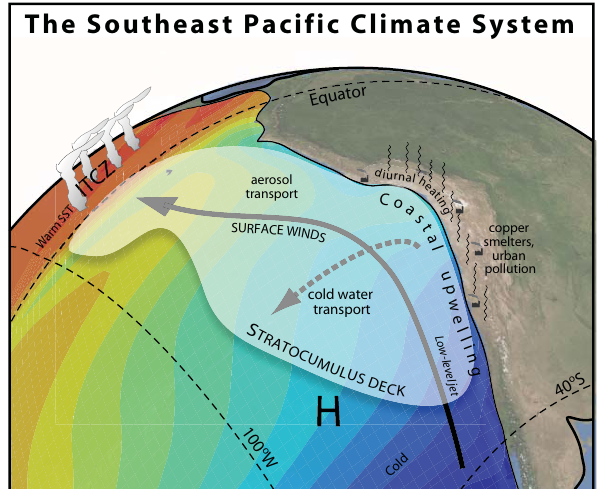
Fig. 1. Key features of the southeast Pacific (SEP) coupled climate system being explored in the VOCALS